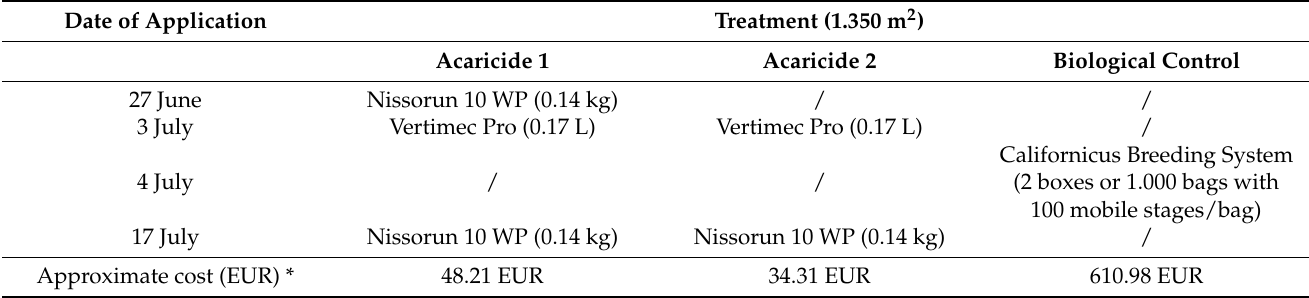
Table 3. Comparison of approximate costs of the application of acaricides and biological control agent single